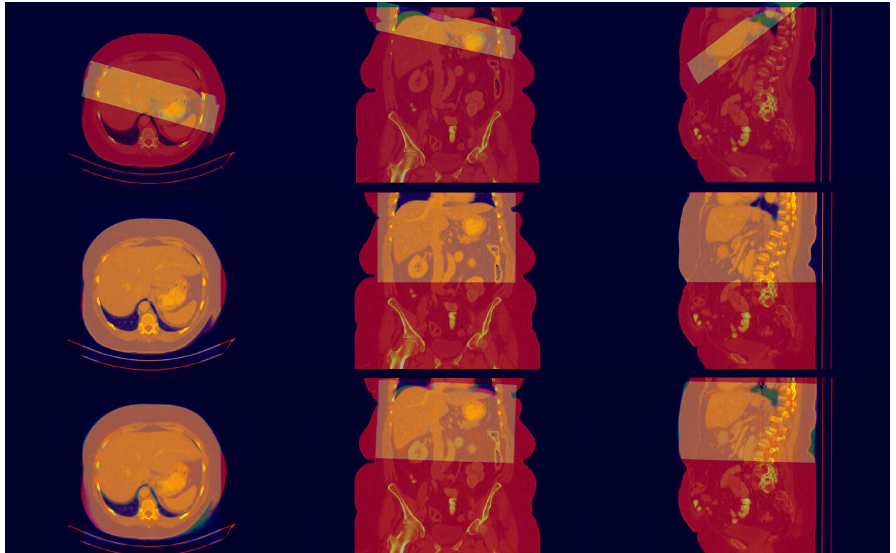
Figure 9. Registration example. The first row displays a poor alignment of the thin image, while the third row displays an improved registration determined by the extrapolation. The middle row presents a very accurate registration of the ground truth full image for